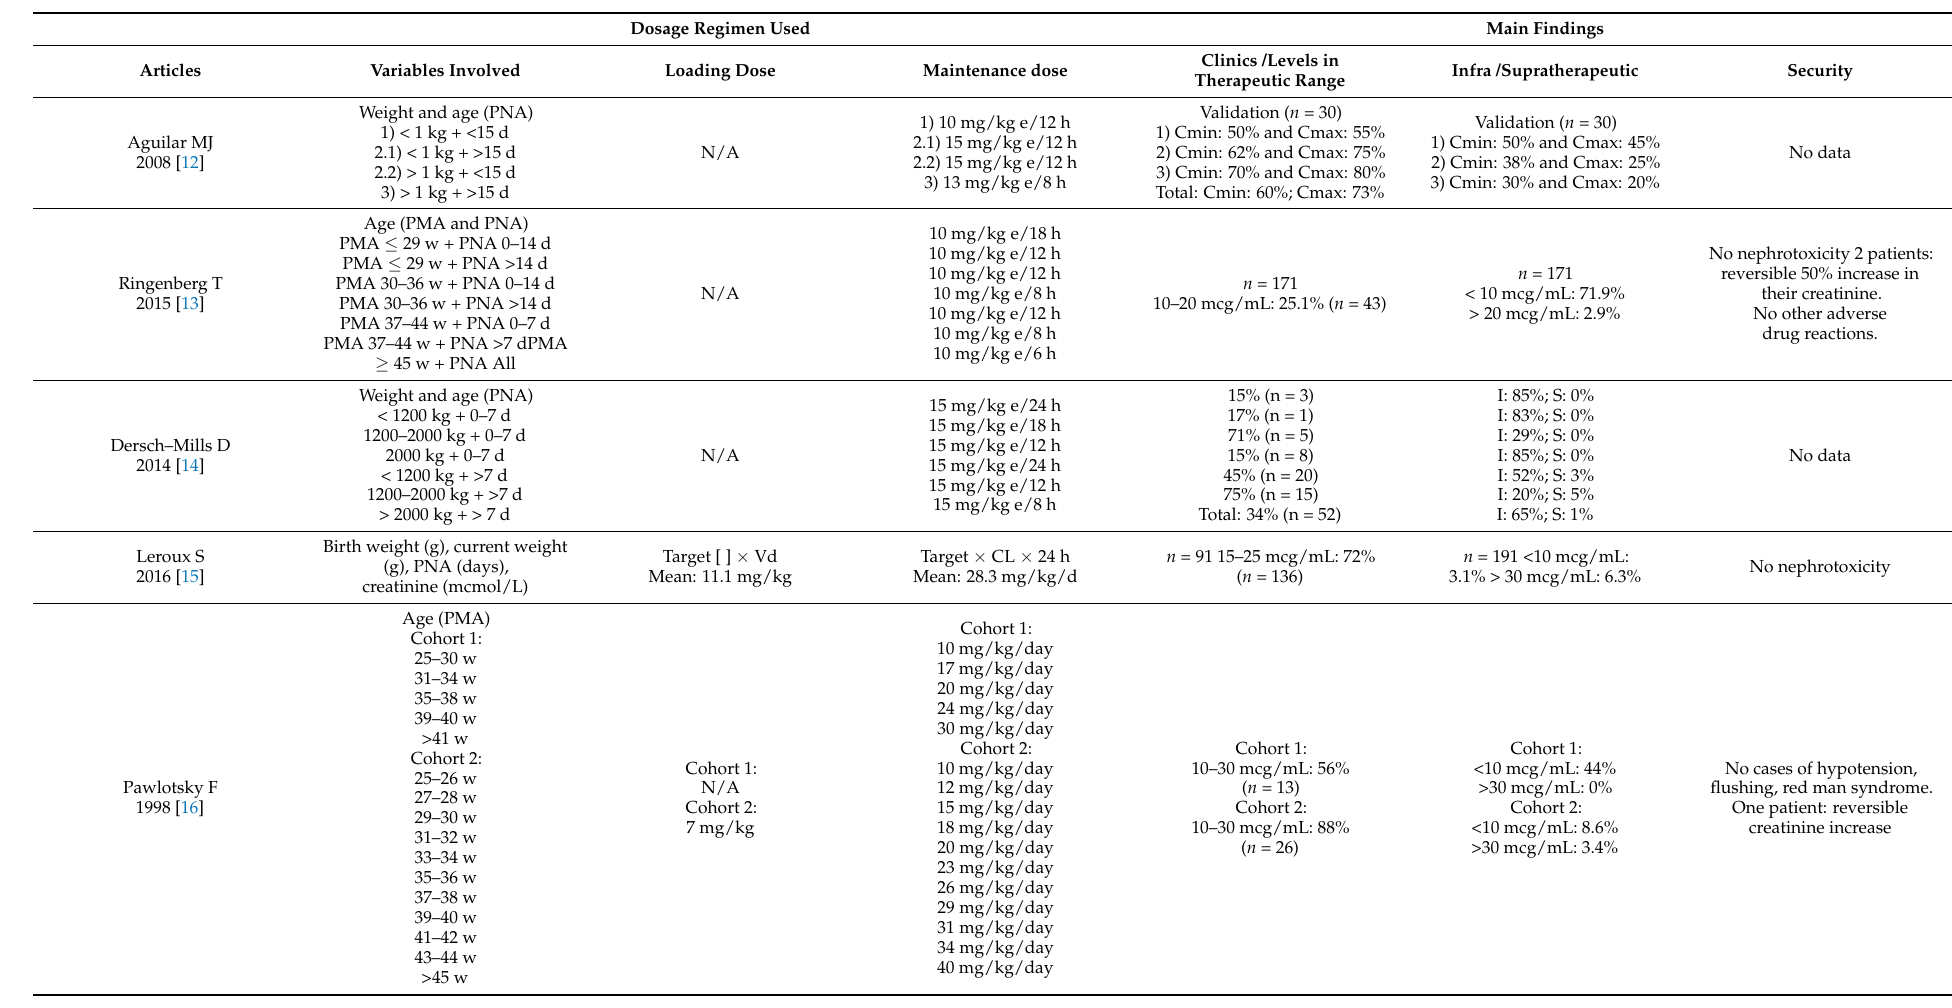
Table 3. Dosage regimen used and main findings of each of the identified